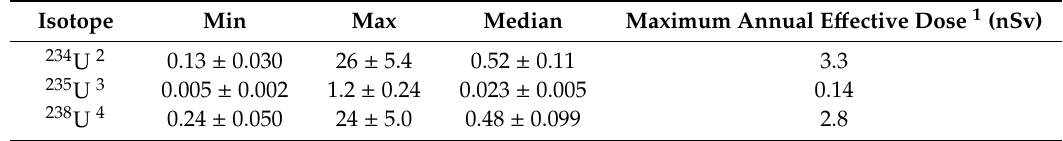
Table 6. Activity concentrations for uranium analysed in bottled water (mBq /